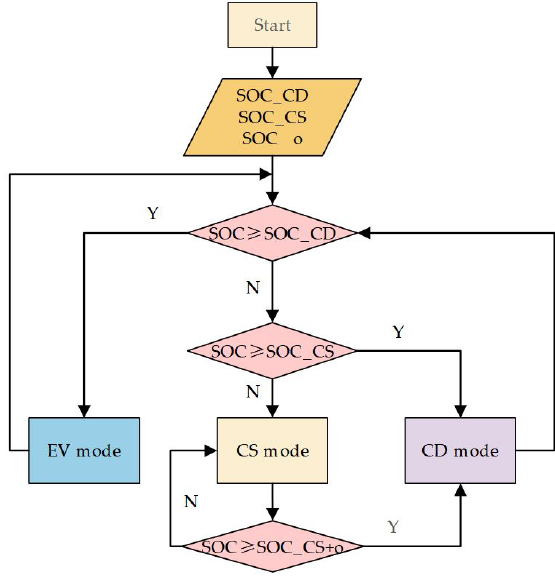
Figure 2. Mode-switching control of the logic threshold